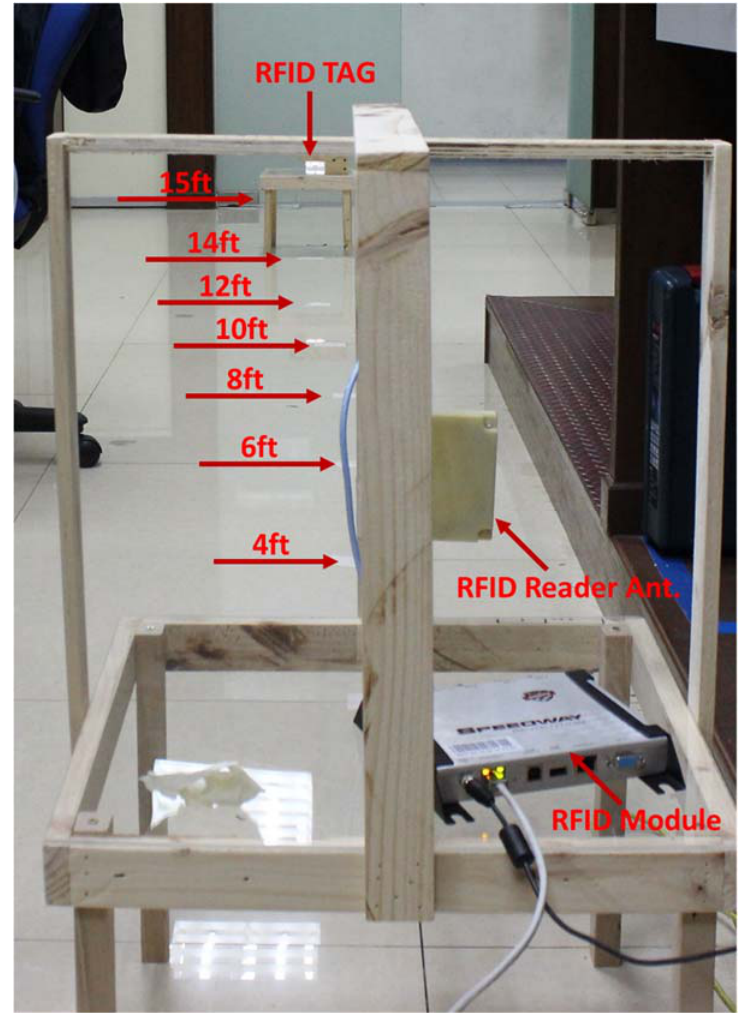
Figure 6. Read range measurement setup.